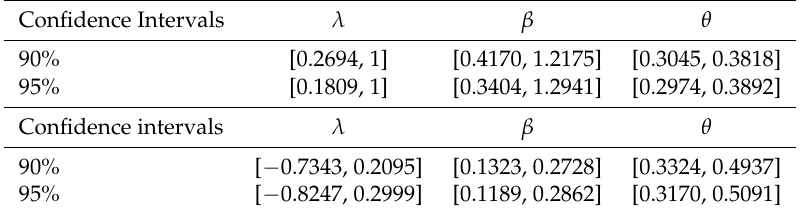
Table 12. Asymptotic two-sided confidence intervals of the TOFrE model parameters at level 90% and 95% for Data sets I and II, respectively.